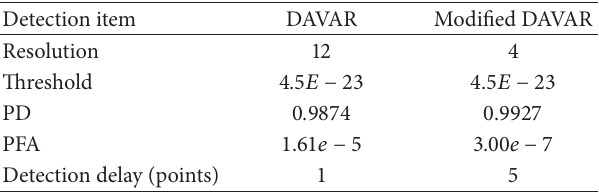
Table 7: Detection performance for phase